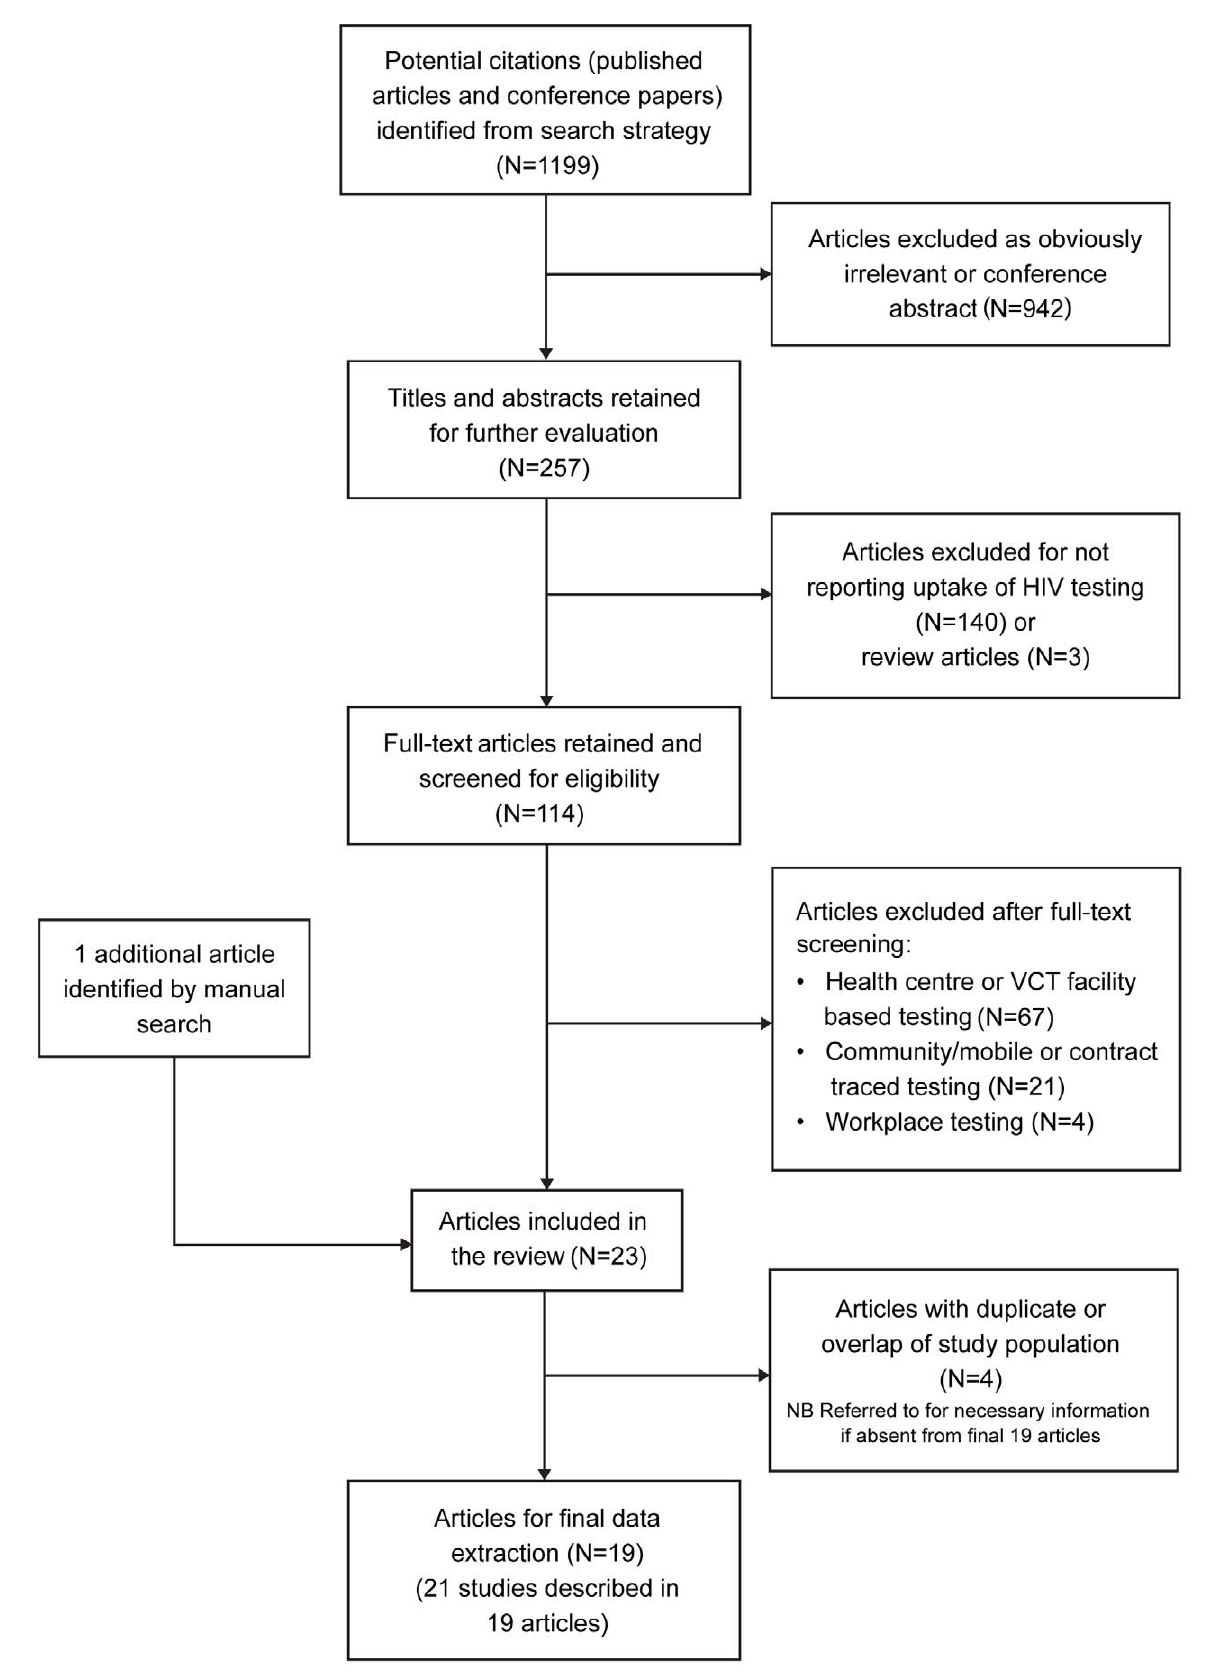
Figure 1. Flow diagram of study selection process. doi:10.1371/journal.pmed.1001351.g001 PLOS Medicine | www.plosmedicine.org